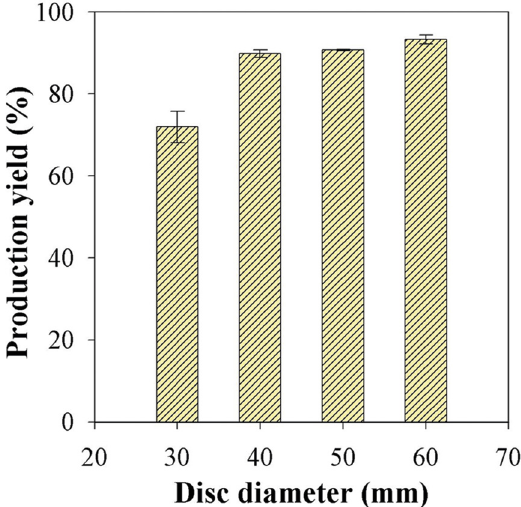
Figure 11. Effect of atomising disc diameter on production yield of zinc powder with 30,000 rpm rotating speed, 50 kg/hr melt feed rate, and 550 o C melt